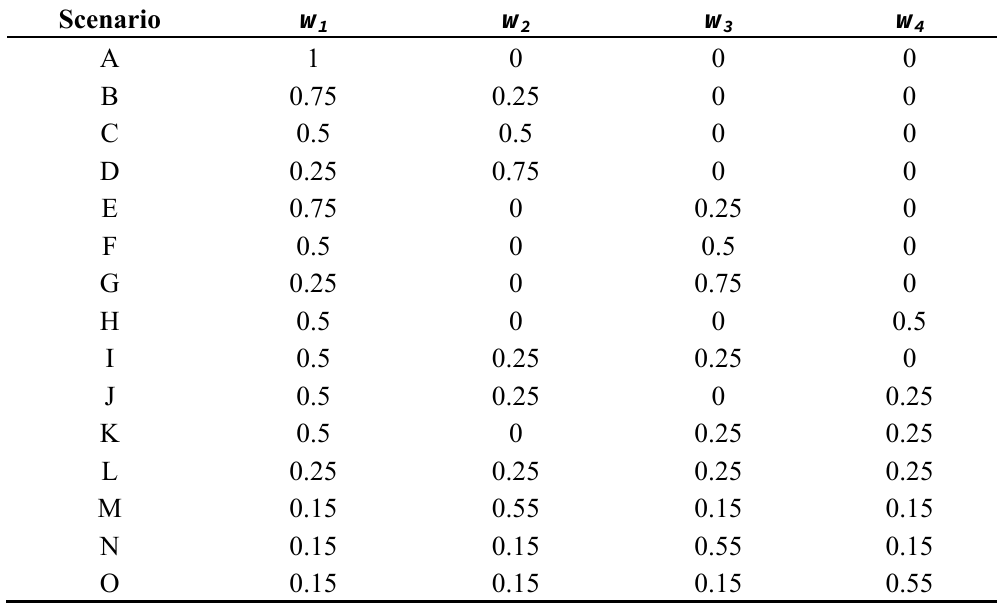
Table 8. Objective weighting schemes used in the MOPSO-CCM optimization.